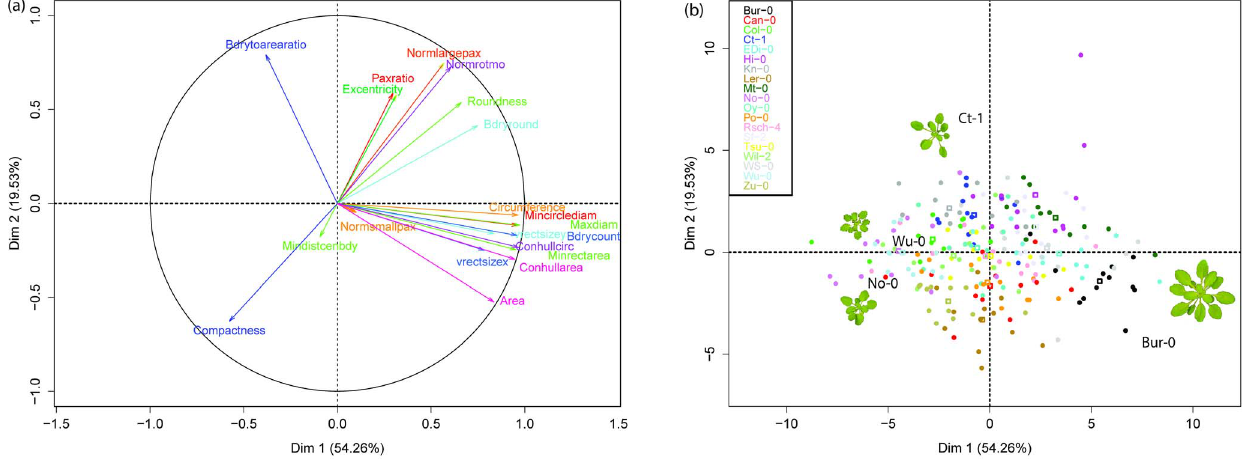
Figure 6. Principal Component Analysis. (A) Variable loadings for first and second principal components, 17 DAS and (B) Analysis by ecotype over first and second principal components, 17 DAS. Significance level is given by the size of the squares, the smaller the square the more significantly different (P , 0.05). (C) Contrast in ‘Area’ between ‘Bur-0’ and ‘Wu-0’ and Contrast in ‘Compactness’ between ‘Ct-1’ and ‘No-0’) and where both ecotypes have similar Area as demonstrated in plot (A).